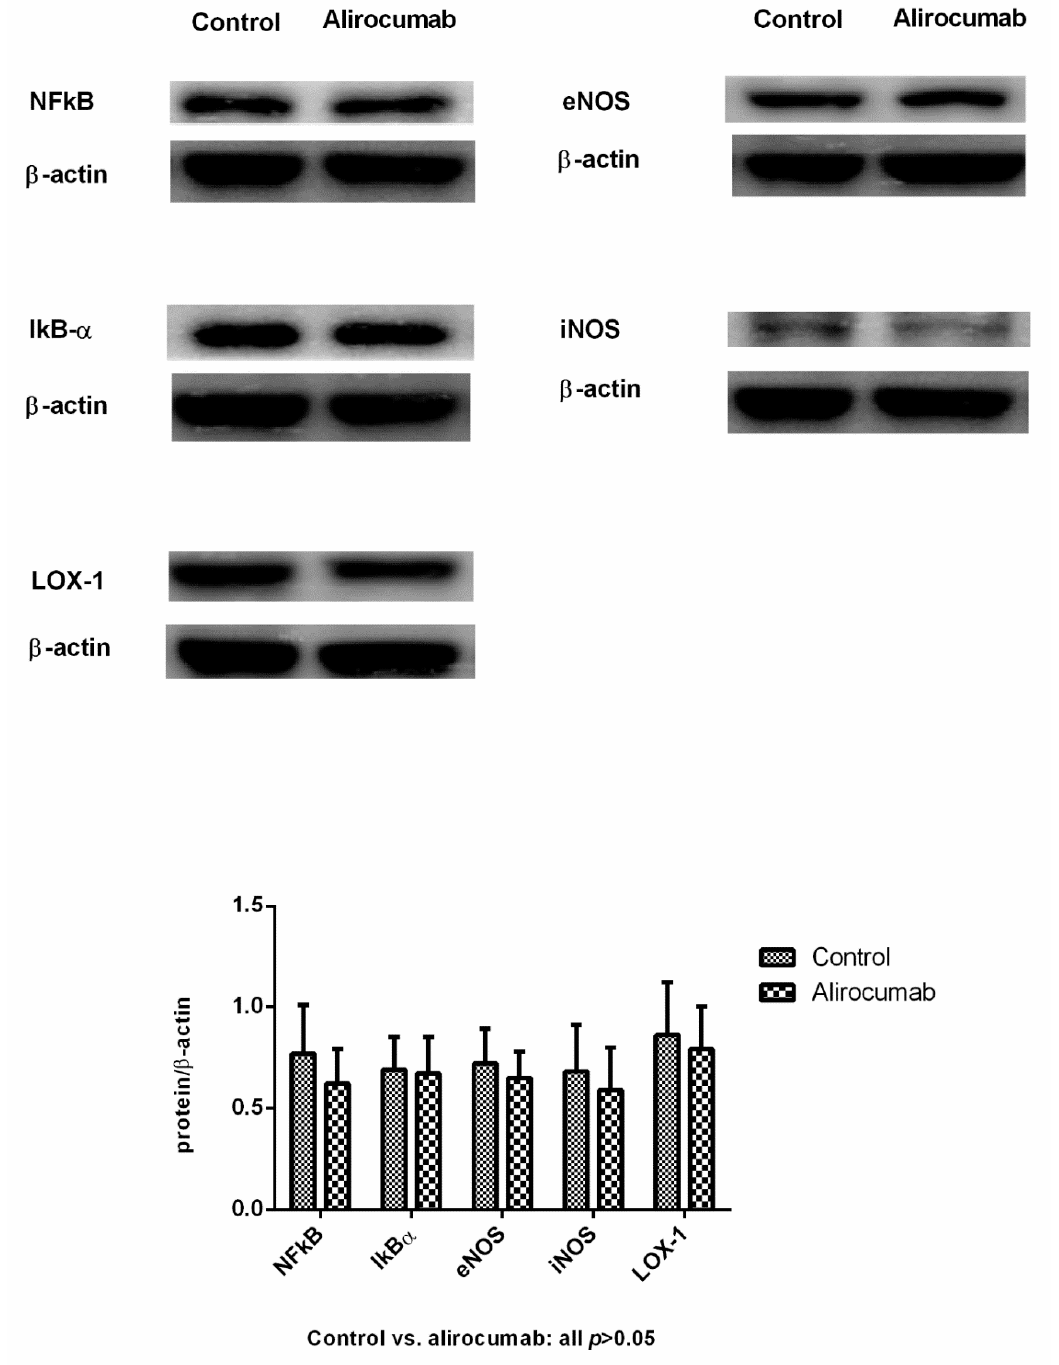
Figure 5. Hepatic protein expressions of BDL rats with or without alirocumab treatment. The NFkB, IkB α , eNOS, iNOS, and LOX-1 protein expressions were not significantly influenced by alirocumab (BDL-V vs. BDL-A: n = 11:12, BDL-V vs. BDL-A, all proteins p > 0.05).